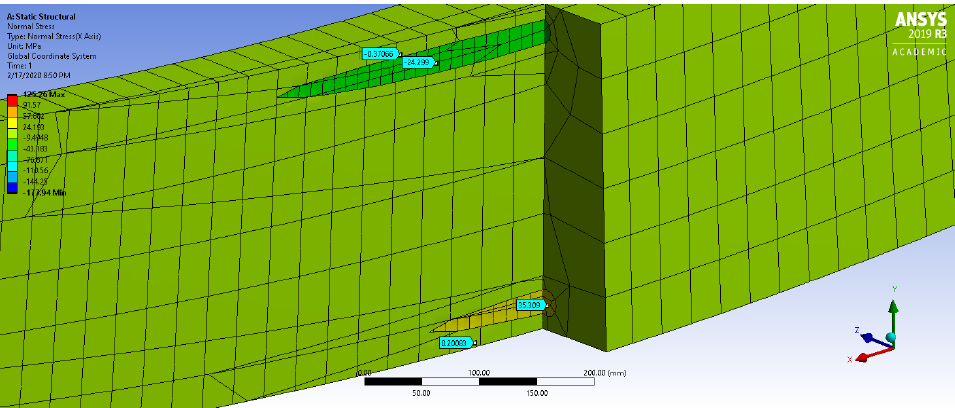
Figure 10. A section cut near the center of the beam for the double-rod configuration with glass reinforcement in the top plate and steel in the bottom. Probe values are shown in MPa.